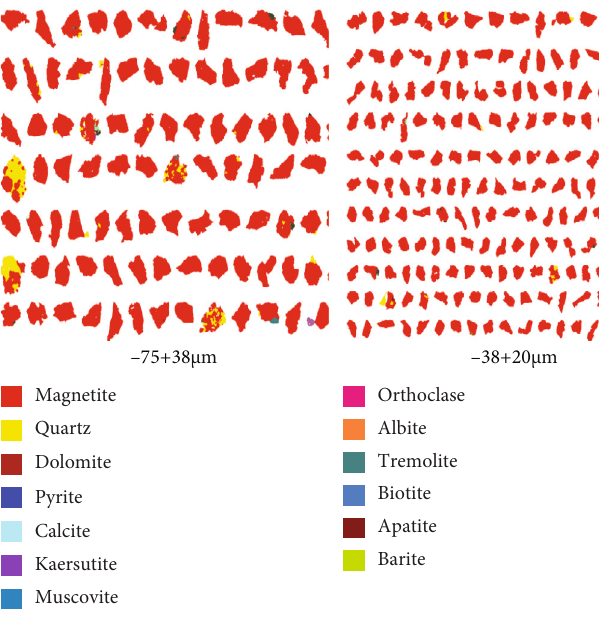
Figure 6: MLA image of liberation characteristics of the magnetite